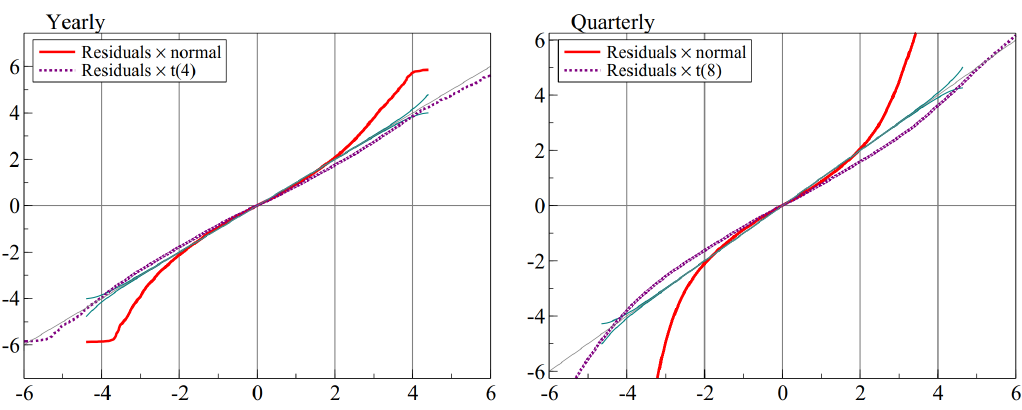
Figure 6. QQ plots of annual and quarterly residuals against Normal and closely matching Student-t distribution, t(4) for yearly and t(8) for quarterly